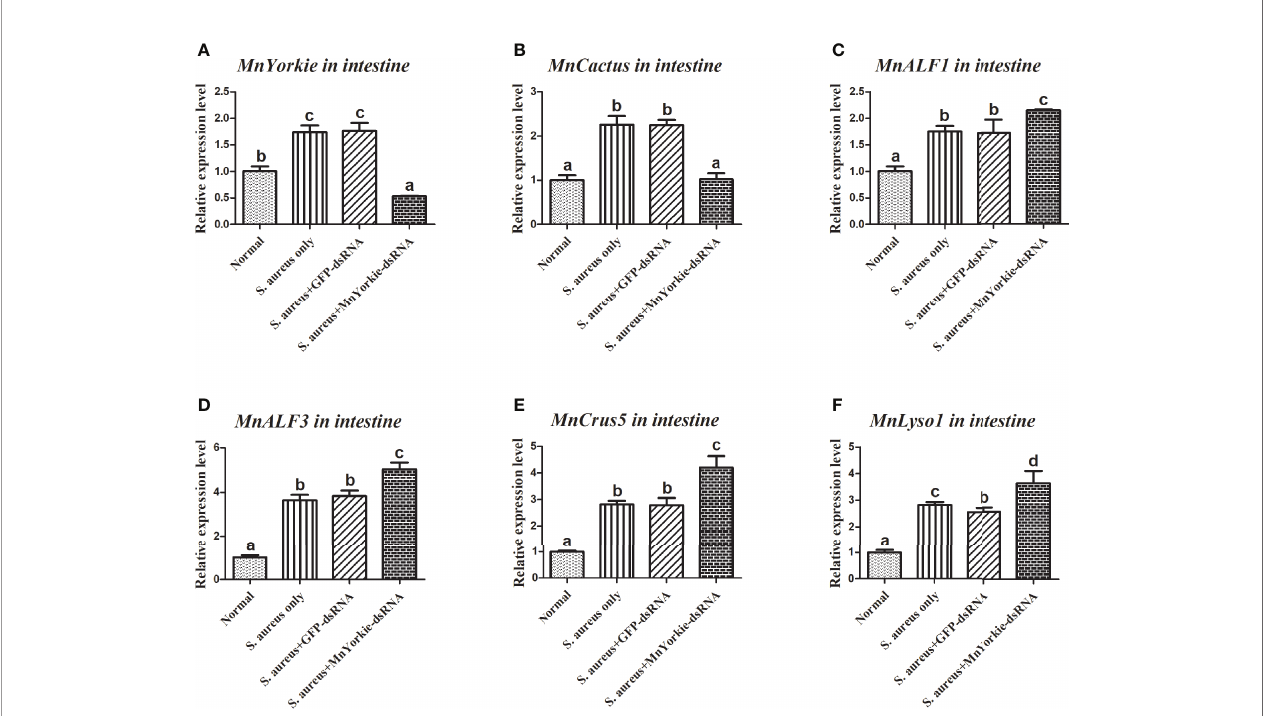
FIGURE 8 | Analysis of MnCactus and four immune-related genes expression levels after MnYorkie RNAi. (A) Ef fi ciency of RNAi detected by RT-qPCR in intestine at 36 h post of MnYorkie -dsRNA and S. aureus injection. The mRNA expression levels of MnCactus (B) , MnALF1 (C) , MnALF3 (D) , MnCrus5 (E) , MnLyso1 (F) were analyzed by RT-qPCR at 24 h injection of S. aureus post MnYorkie RNAi. Signi fi cance differences were compared between the normal group to other treated groups at the same time point. Signi fi cant differences were marked with different letters (a, b, c,